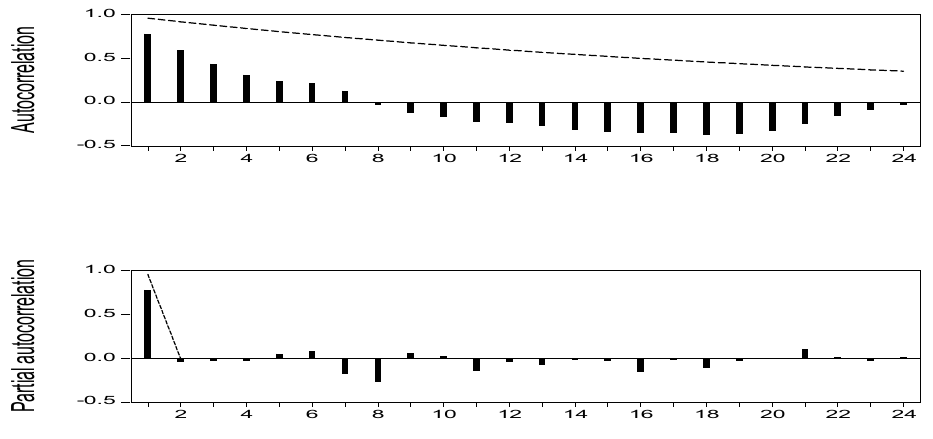
Fig. 5. Computer group ARMA